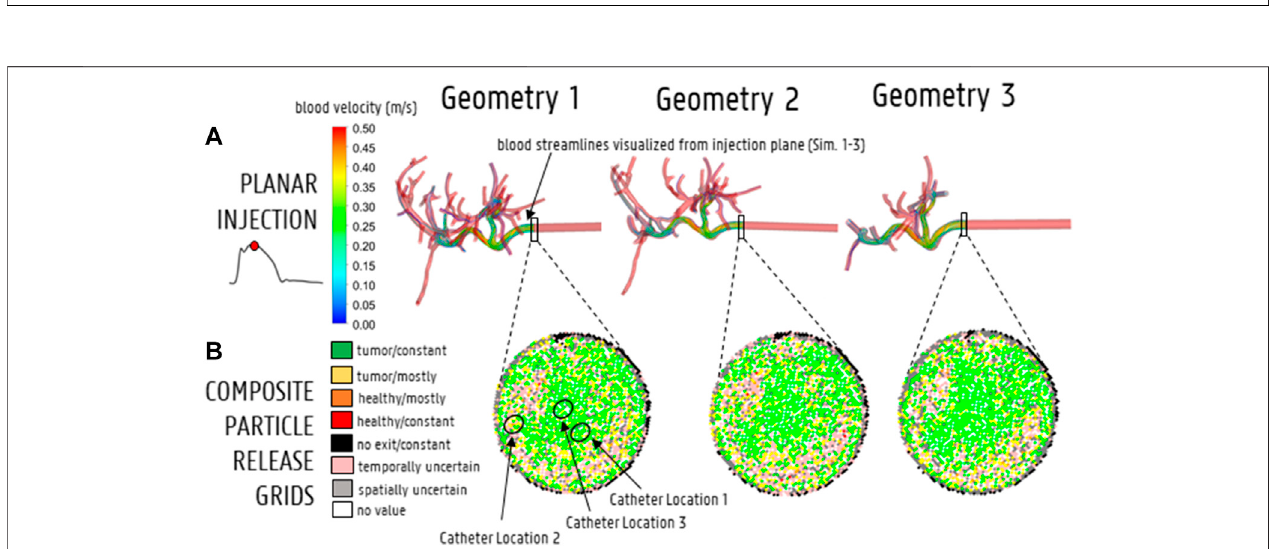
FIGURE 7 | (A) Streamline visualization at peak systole for particle release at the injection plane for Geometry 1 – 3 (Sim. 1 – 3). (B) The CPRGs for the 3 geometries show thatparticles injected at thecenterofthecross-section(green zone)leadto > 75%oftumor targetingthroughout thecycle.Comparing CPRGs, consistencyofthe major visual trends across all geometries is visible, with only minor